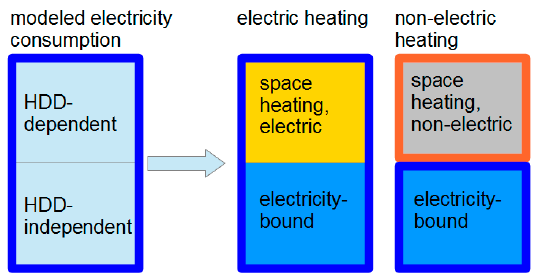
Figure 3. Modeling electricity ‐ bound and space heating energy consumption.